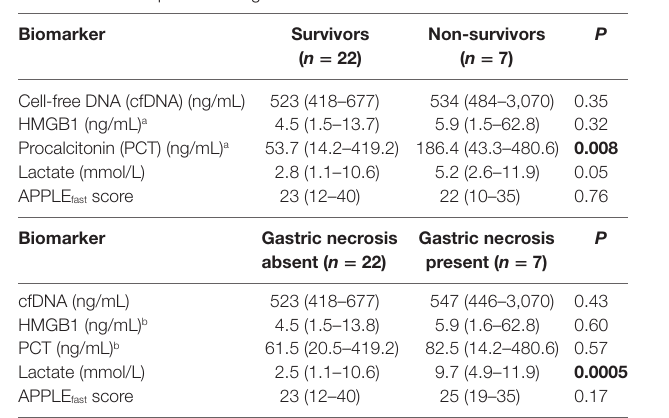
FigUre 2 | Box and whisker plot comparison of plasma procalcitonin (PCT) concentrations in 28 dogs with gastric dilatation–volvulus syndrome categorized as survivors ( n = 21) and non-survivors ( n = 7). The central line represents the median, the boxes represent the interquartile range, and the whiskers represent the minimum and maximum values. * indicates statistical significance at P < 0.05. Non-survivors had significantly greater plasma concentrations of PCT compared to survivors by Mann–Whitney U -test ( P = 0.008).